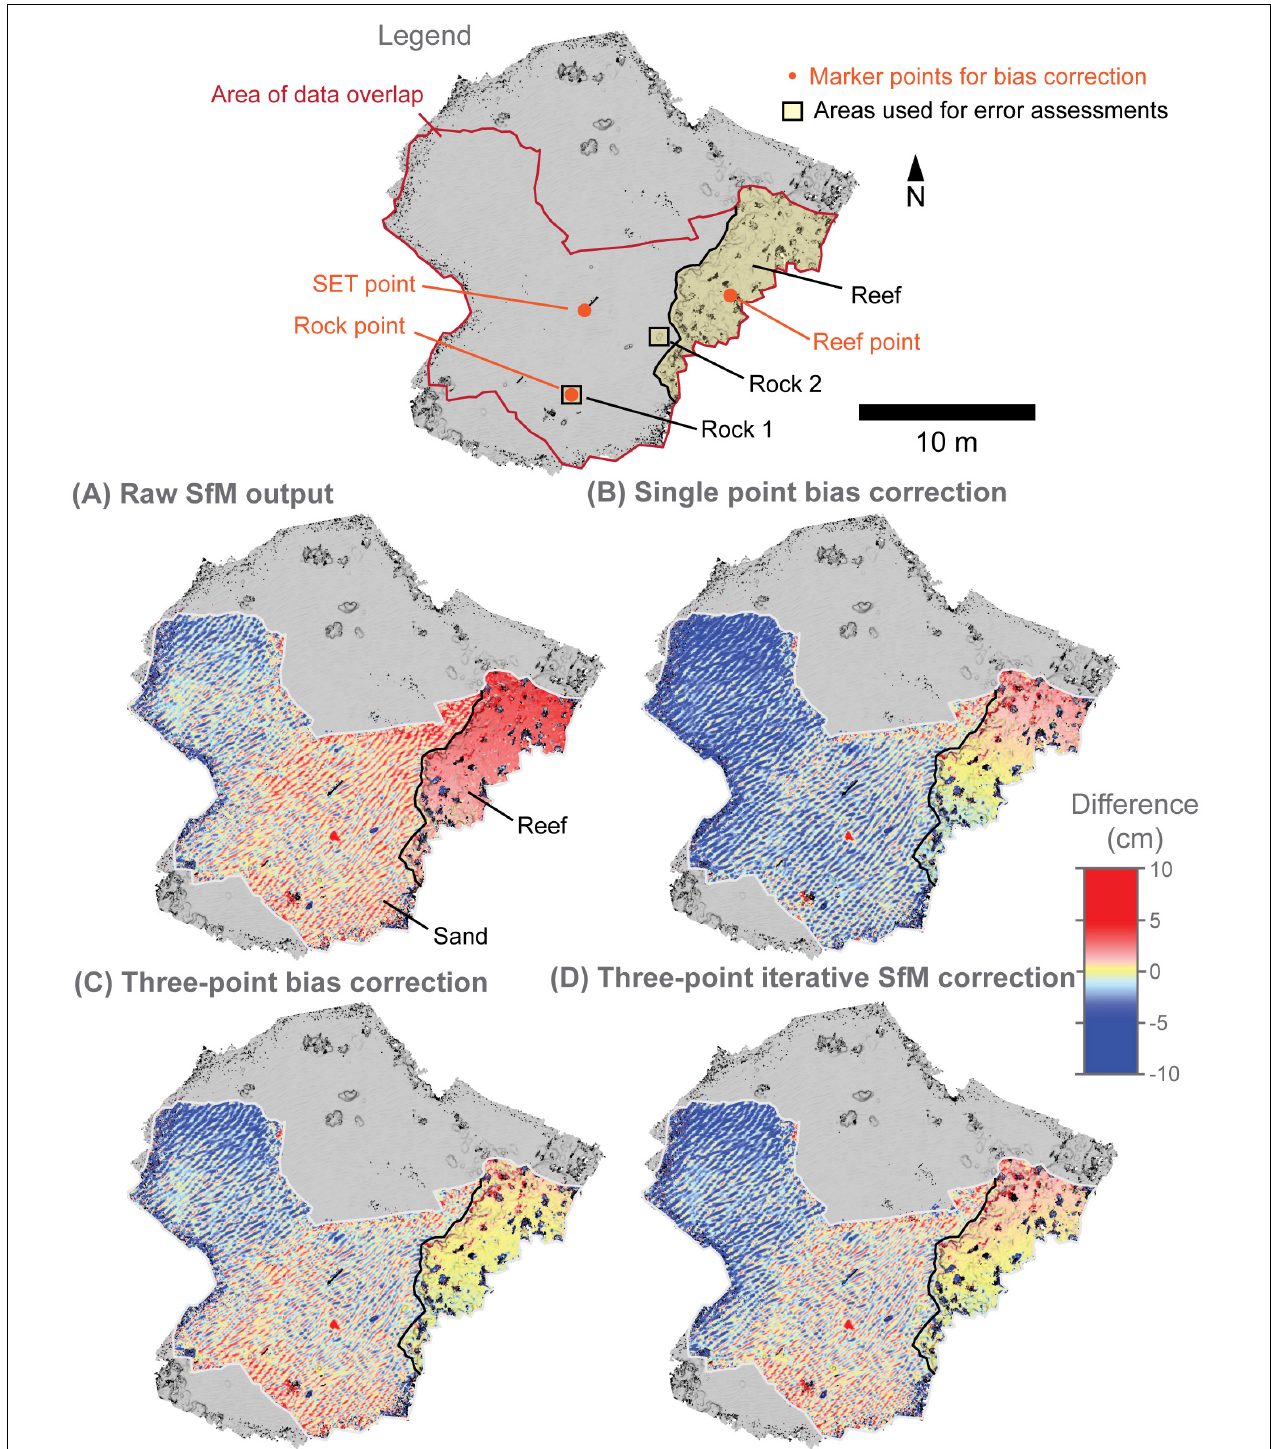
FIGURE 10 | Difference measurements of the Surface Elevation Table (SET) station 1 site point clouds using the M3C2 measurement tool to test for reproducibility. The legend shows the area of data overlap for the surveys, marker points used for bias correction, and the three areas used for error computations. (A–D) Difference maps for the four comparative techniques, including raw Structure-from-Motion (SfM) output, single-point bias correction, three-point bias correction, and three-point iterative SfM correction. In each map, the reef area is highlighted with a black line.